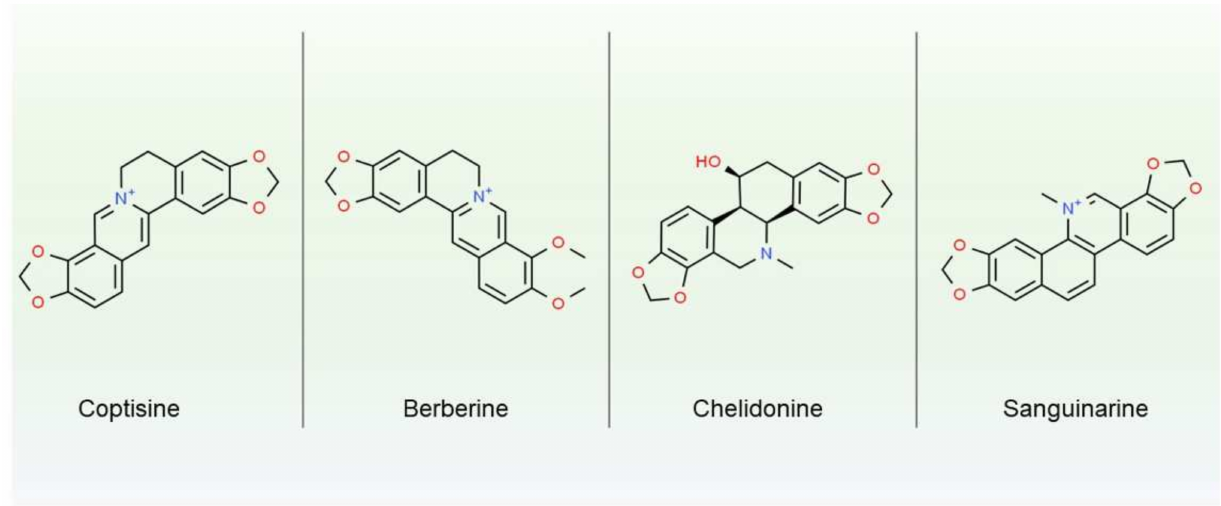
Figure 1. Chemical structure of four most studied alkaloids from Chelidonium majus